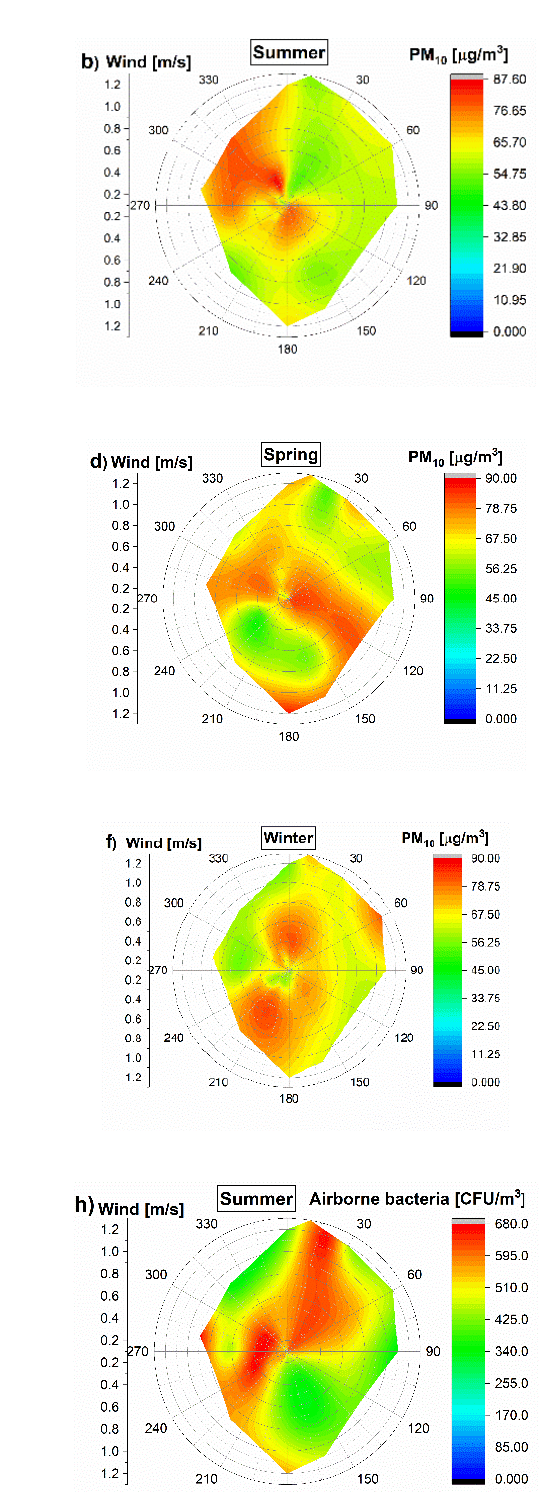
Figure 1. Sampling locations (A, B and C group for indoors of childcare, school, commercial building, elderly and homes for indoors and O for outdoor) with the plots of outdoor PM 10 using R statistical software and Microsoft 3D